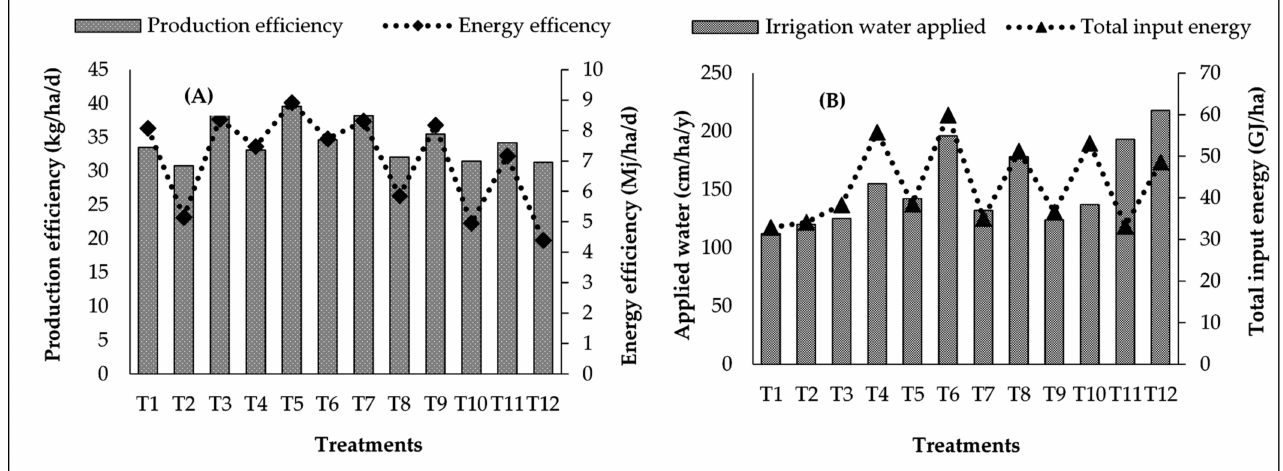
Figure 4. ( A ) Production efficiency and energy-use efficiency and ( B ) total input energy and irrigation water applied under the experimental cropping systems and land leveling